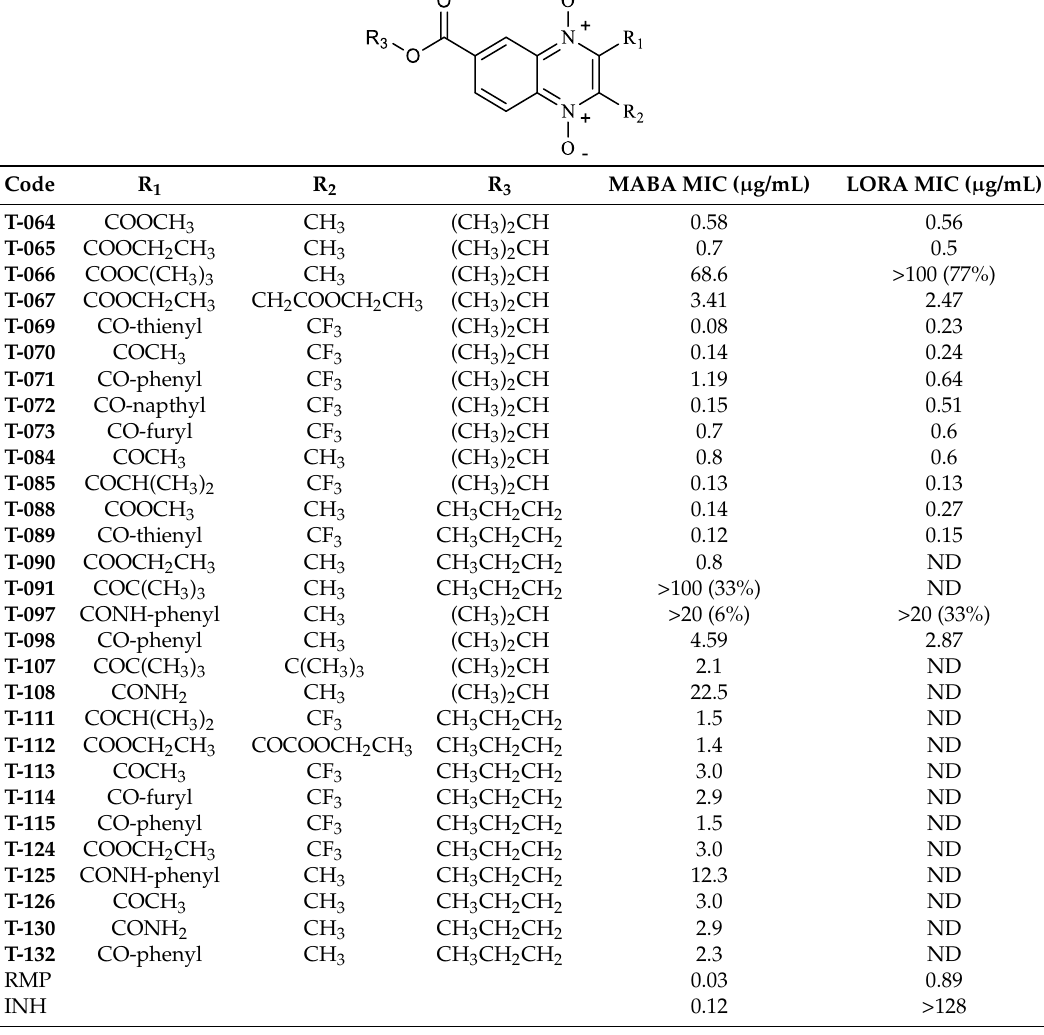
Table 3. Biological activity of isopropyl and n-propyl quinoxaline-7-carboxylate 1,4-di- N -oxide derivatives using the MABA against Mycobacterium tuberculosis strain H37Rv and the LORA against nonreplicating persistent strain.